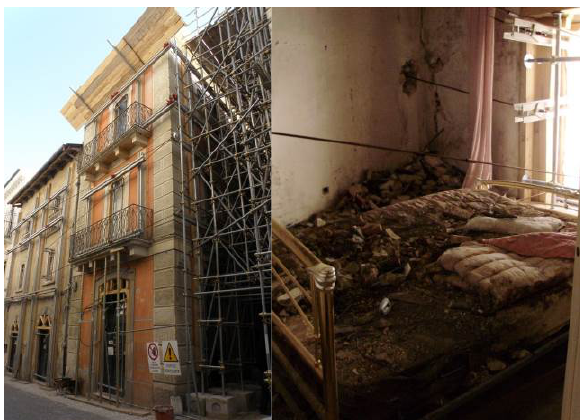
Figure 3. Photograph of a portion of the main facade and the invasive scaffolding put up to allow safety work on the side elevation (left). Photograph of an interior room in which part of the small roof vaults collapsed